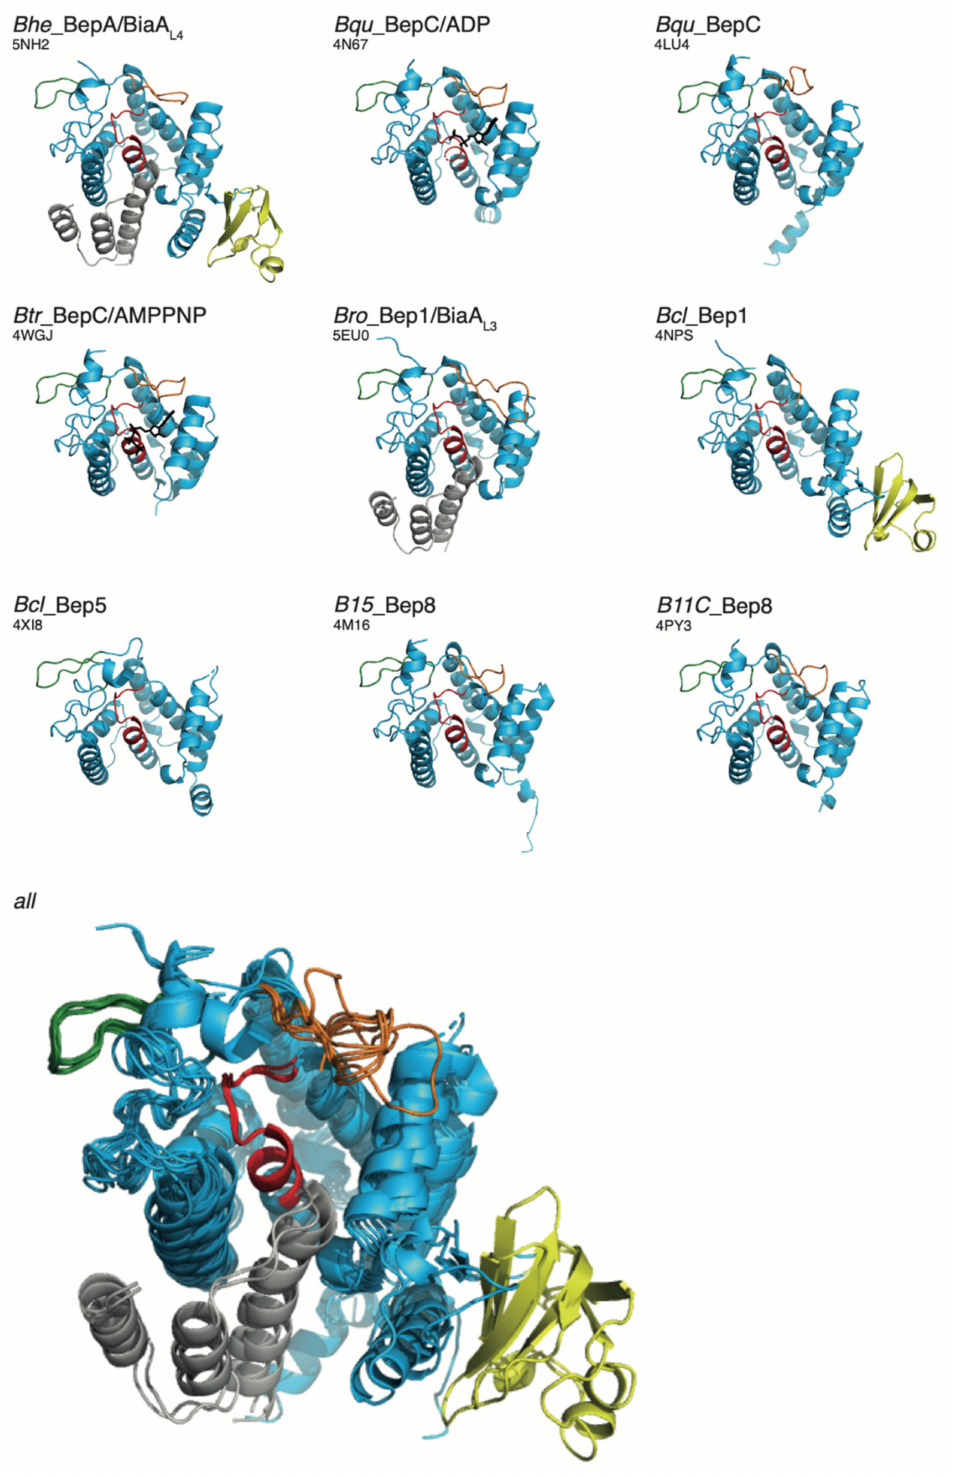
Figure 5. Crystal structures of BepFIC domains from various Bep sub-clades. The proteins are named according to the code provided in Table S2 and PDB codes are provided in parentheses. The structures are represented as in Figure 2. The BepFic structures of Bhe _BepA and Bro _Bep1 have been determined in complex with their cognate anti-toxins (grey) BiaA L4 and BiaA L3 , respectively. The structures of Bhe _BepA and Bcl _Bep1 encompass the BepFIC and the OB-fold in yellow (see also [6]). A superposition of all structures onto Bhe _BepA (using α 4, Fic loop, and α 5) is shown at the bottom. All structures with the exception of 5EU0 [16] have been determined in this study and crystallographic details are provided in Table